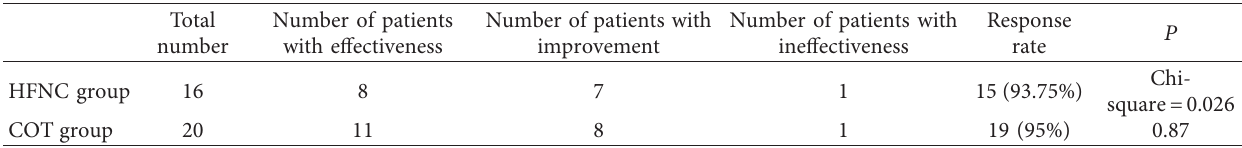
2 and PCO 2 in severe asthma exacerbation patients combined with respiratory failure.